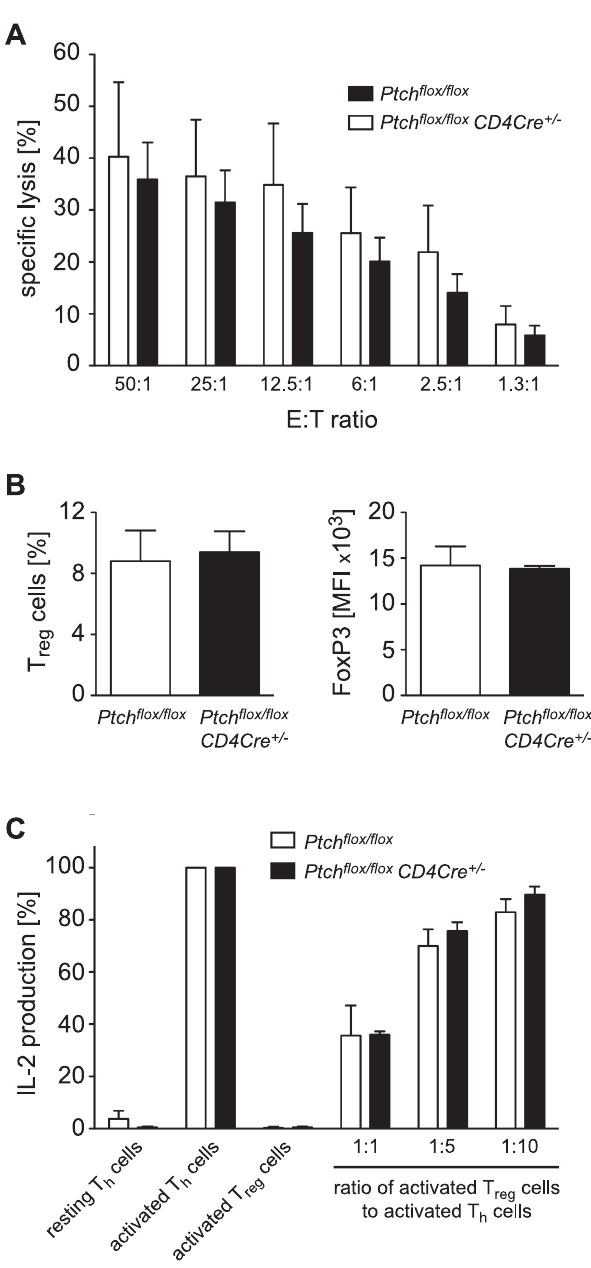
Figure 4. Cytolytic capacity of CTLs and suppressive activity of T reg cells. (A) Specific lysis of Ltk 2 target cells (H2 k ) by alloreactive CTLs derived from Ptch flox/flox control or Ptch flox/flox CD4Cre + / 2 mutant mice (H2 b ), which had been immunized with splenocytes from C3H/HeN mice (H2 k ). Means of specific lysis of triplicates of the Ltk 2 cells